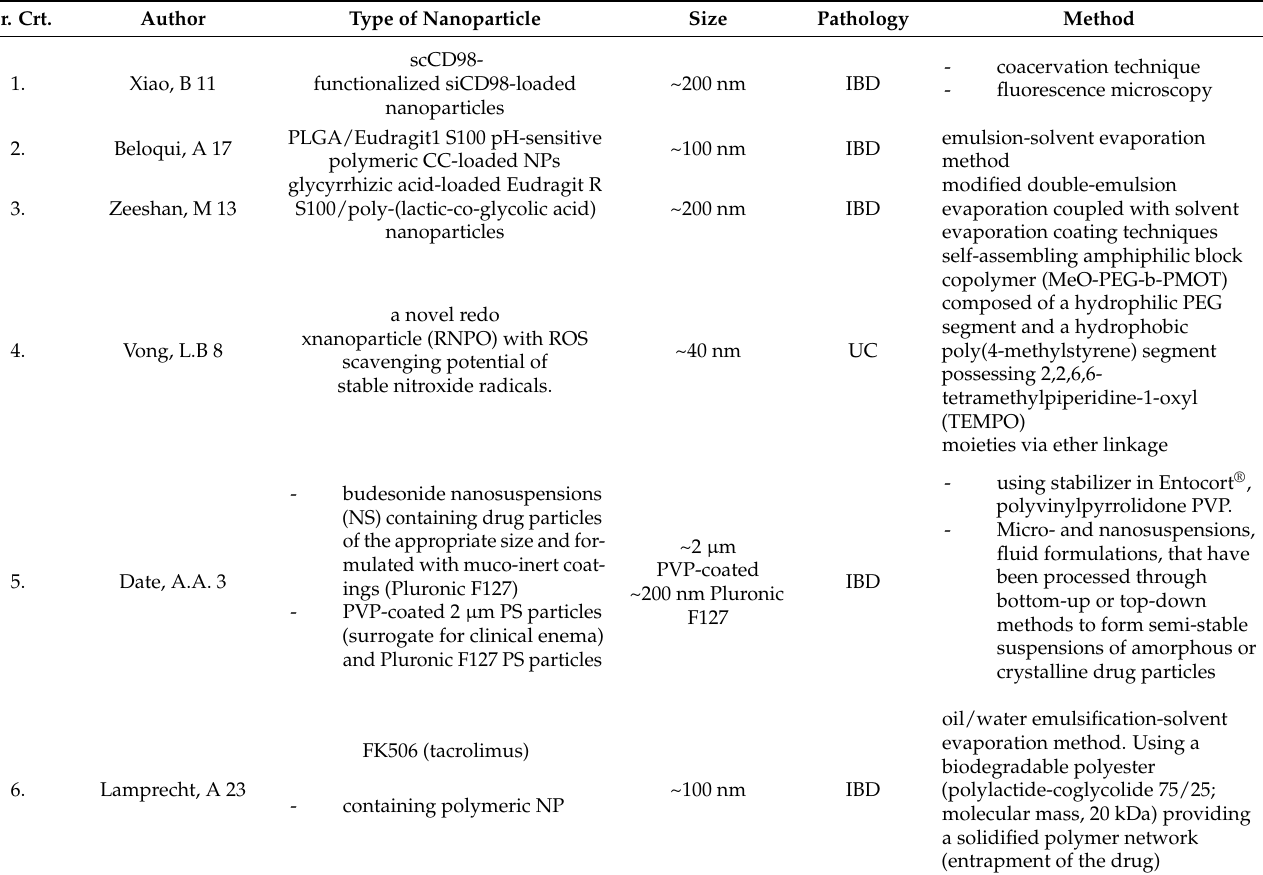
Table 1. Synthesis of most common therapeutic approaches using nanoparticles in inflammatory bowel disease (IBD)